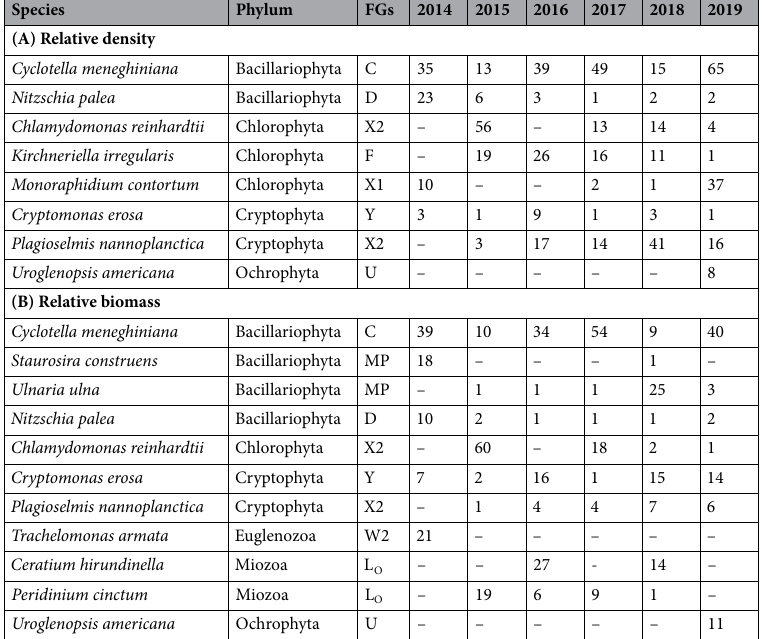
Table 2. The dominant species (mean % for the growth season) in phytoplankton density (A) and biomass (B) in the Kuźnica clarification pond in 2014–2019. FGs functional groups (Reynolds et al. 2002, Padisák et al. 2009) and habitat template of coda, C eutrophic small- and medium sized lakes with species sensitive to the onset of stratification, D shallow turbid waters including rivers, F clear, deeply mixed meso-eutrophic lakes, X1 shallow, eu hypertrophic environments, X2 shallow, meso-eutrophic environments, Y this codon, mostly including large cryptomonads but also small dinoflagellates, refers to a wide range of habitats, which reflect the ability of its representative species to live in almost all lentic ecosystems when grazing pressure is low, MP frequently stirred up, inorganically turbid shallow lakes, W2 meso-eutrophic ponds, even temporary, shallow lakes, L O deep and shallow, oligo to eutrophic, medium to large lakes, U stratifying oligotrophic and mesotrophic lakes, where nutrient resources are exhausted in the upper layers but still available in the darker deep ones, the essential adaptation under these conditions is the combination of motility with large size, – not